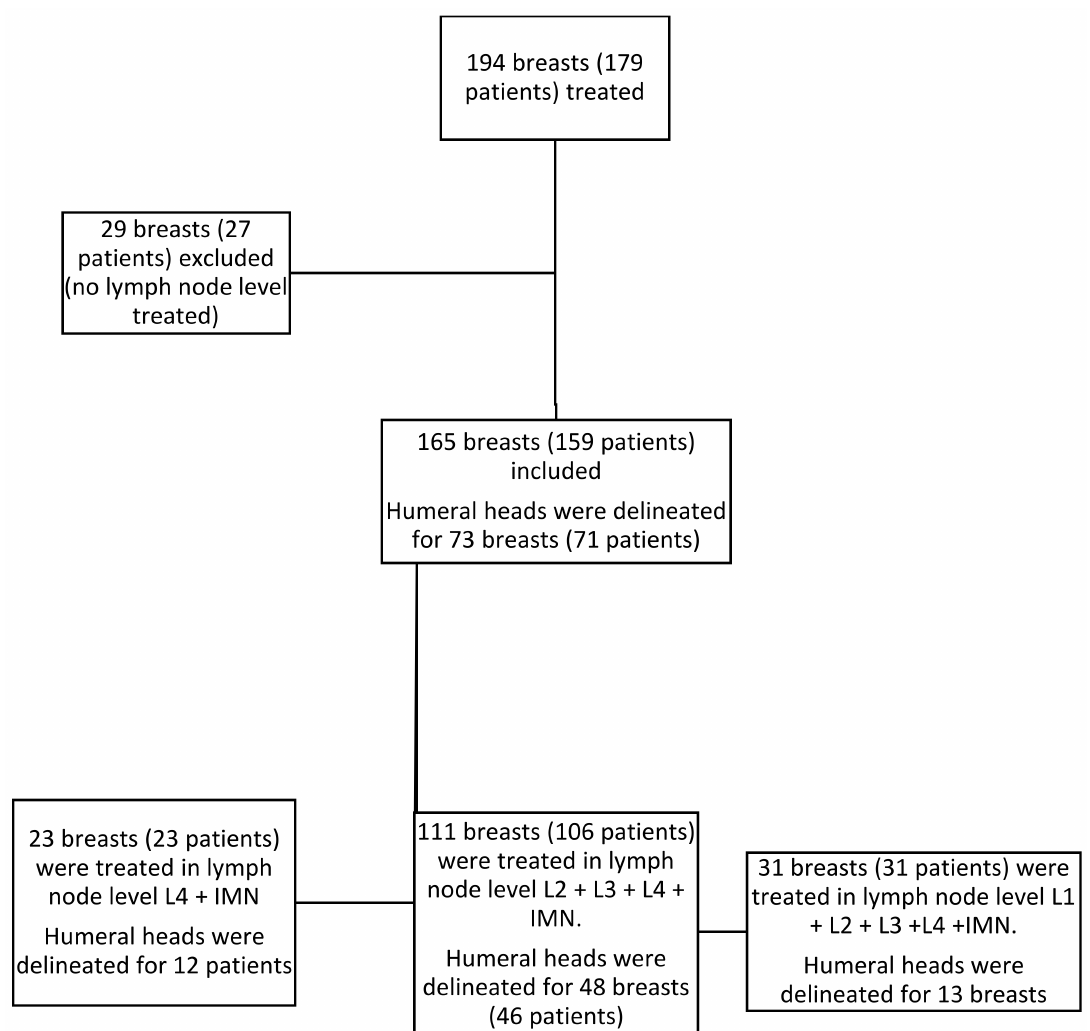
Figure 1. Flowchart describing the number of patients and breasts treated according to lymph node station. The humeral heads were contoured for 71 patients (73 breasts). For the needs of this study, some humeral heads were delineated